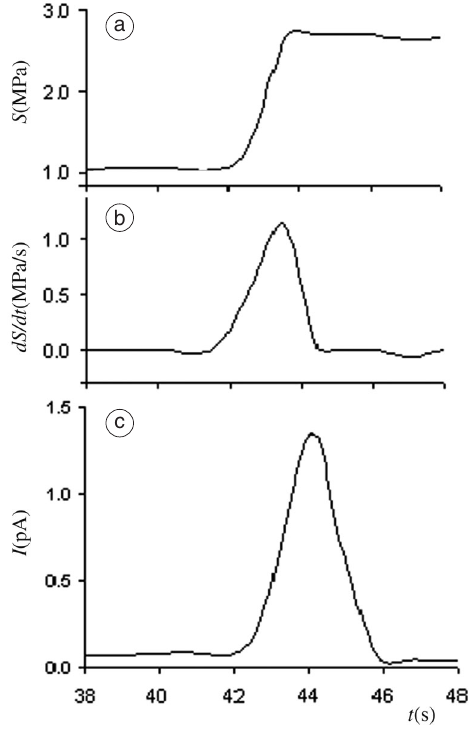
Fig. 2a-c. Time records of (a) stepwise applied stress to Penteli marble sample (MD007), b) the cor- responding stress rate ( ds / dt ) and (c) the emitted